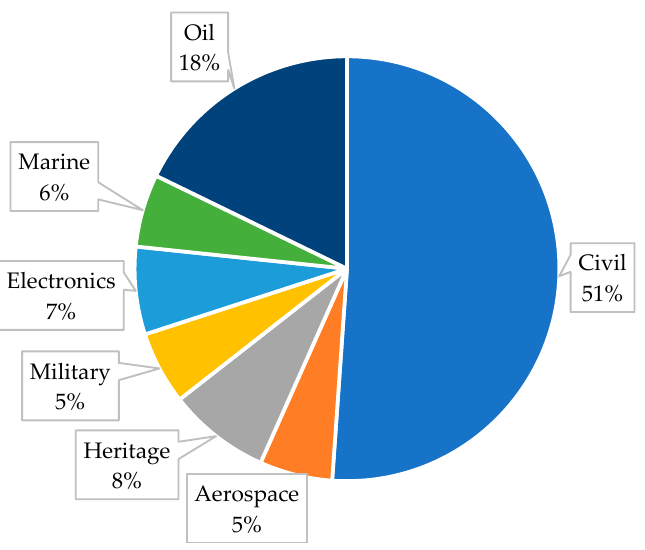
Figure 6. Contribution of the publications on low-cost corrosion monitoring by industry.